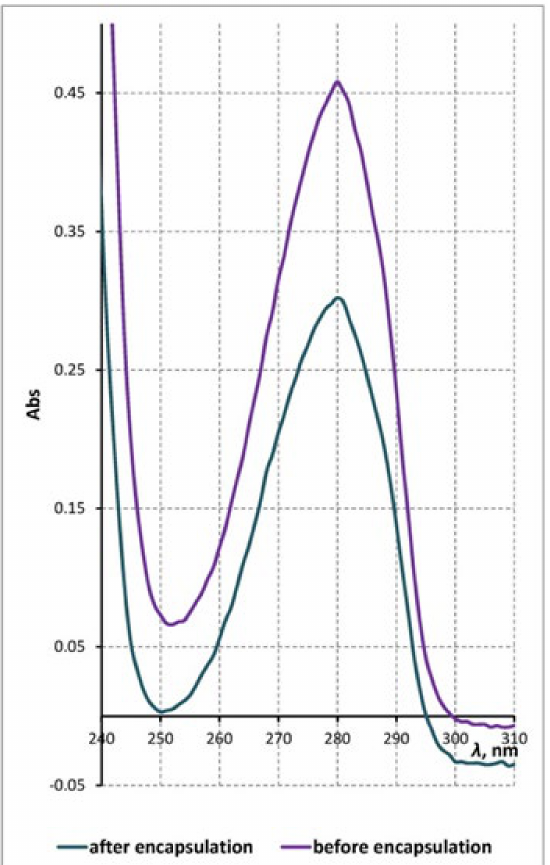
Figure 2. UV-Vis spectra of Acacia catechu extract before ( C 0 = 50 µ g/cm 3 ) and after encapsulation ( C e = 32.7 µ g/cm 3